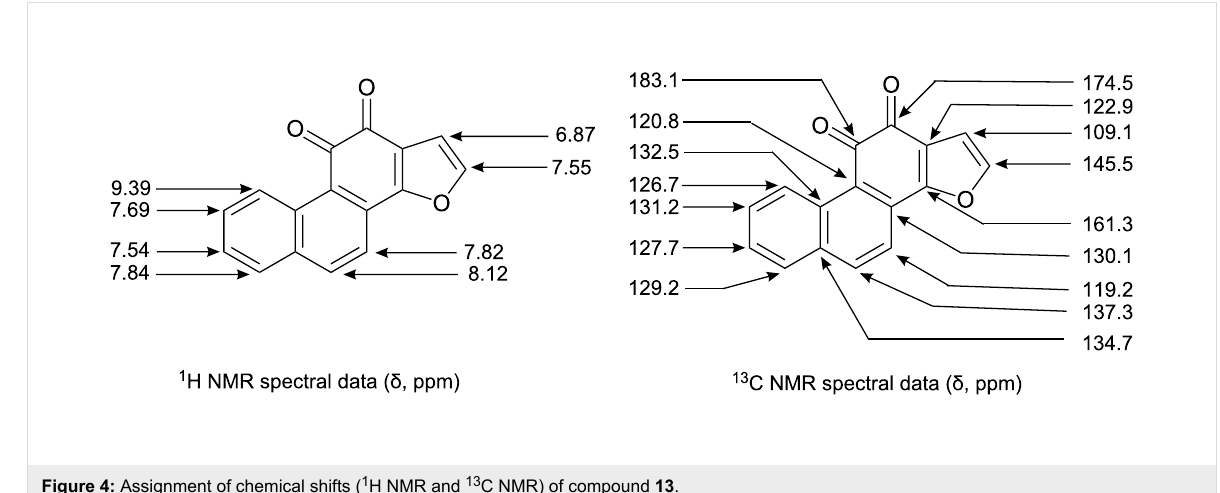
Figure 4: Assignment of chemical shifts ( 1 H NMR and 13 C NMR) of compound 13